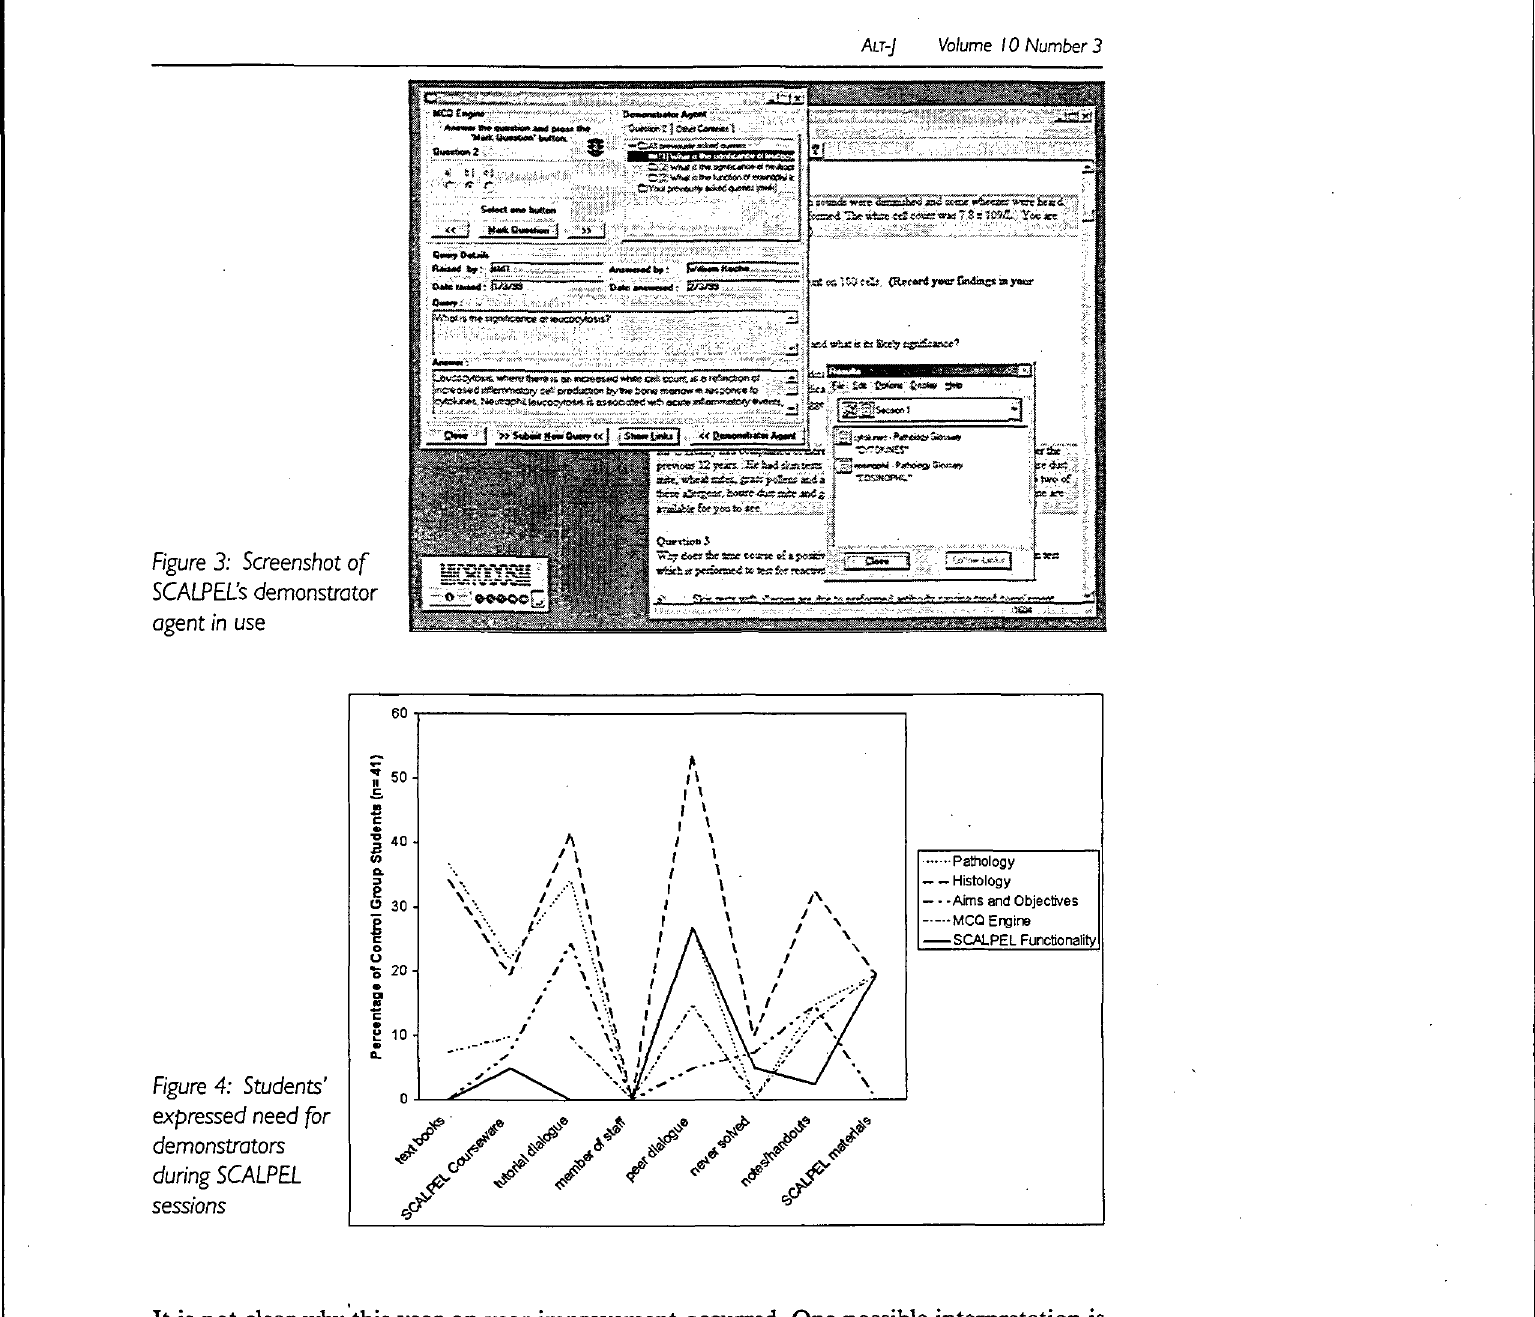
Figure 4: Students' expressed need for during